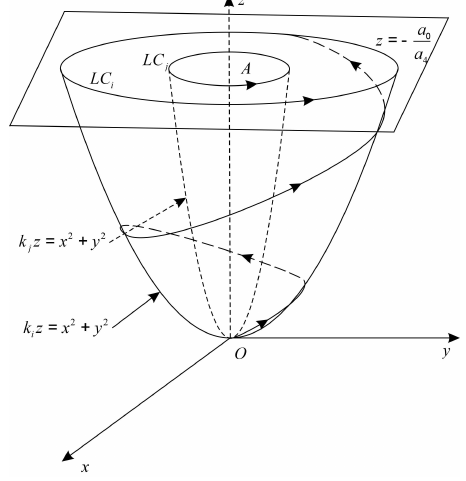
Figure 1. Localization of the limit cycles LC i and LC j as curves of intersection of the invariant plane with the family of invariant paraboloids in the phase space of system (2)